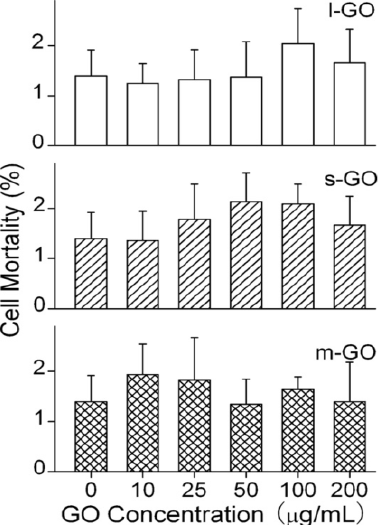
Figure 9. The effects of GO doses and sizes on the mortality of A549 cells. Reproduced from [46] with permission of Elsevier.